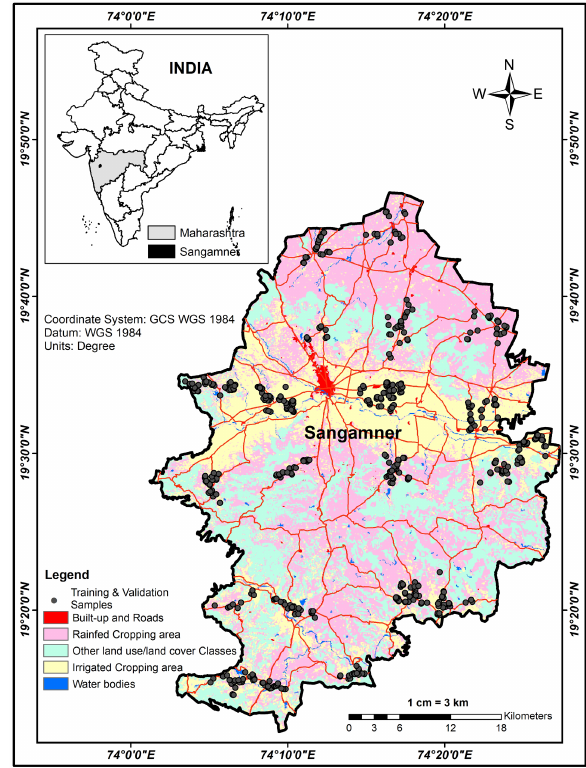
Figure 1. Location of the study area and training samples